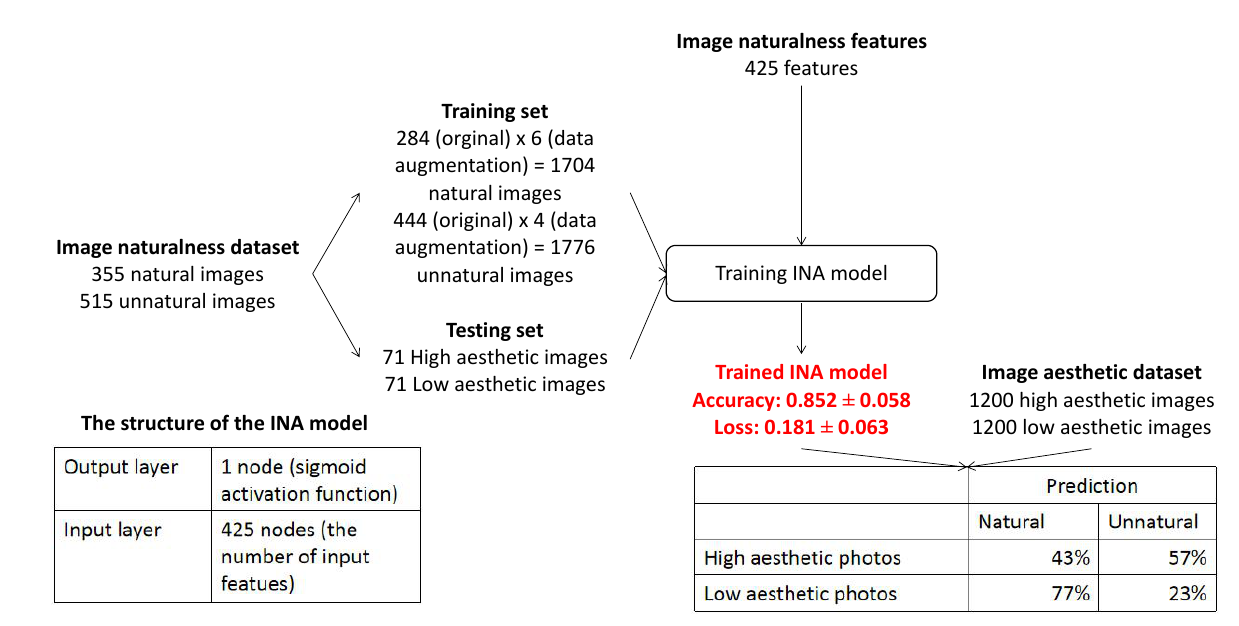
Figure 9. Process of the experiment evaluating the IN of photos in the IA dataset.